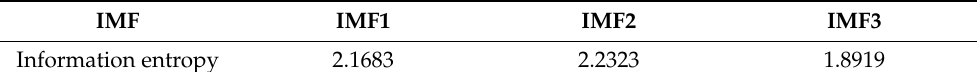
Figure 14. The result of the acoustic signal is decomposed by AVMD. Table 4. Information entropy of each IMF obtained after AVMD decomposes the acoustic signal.